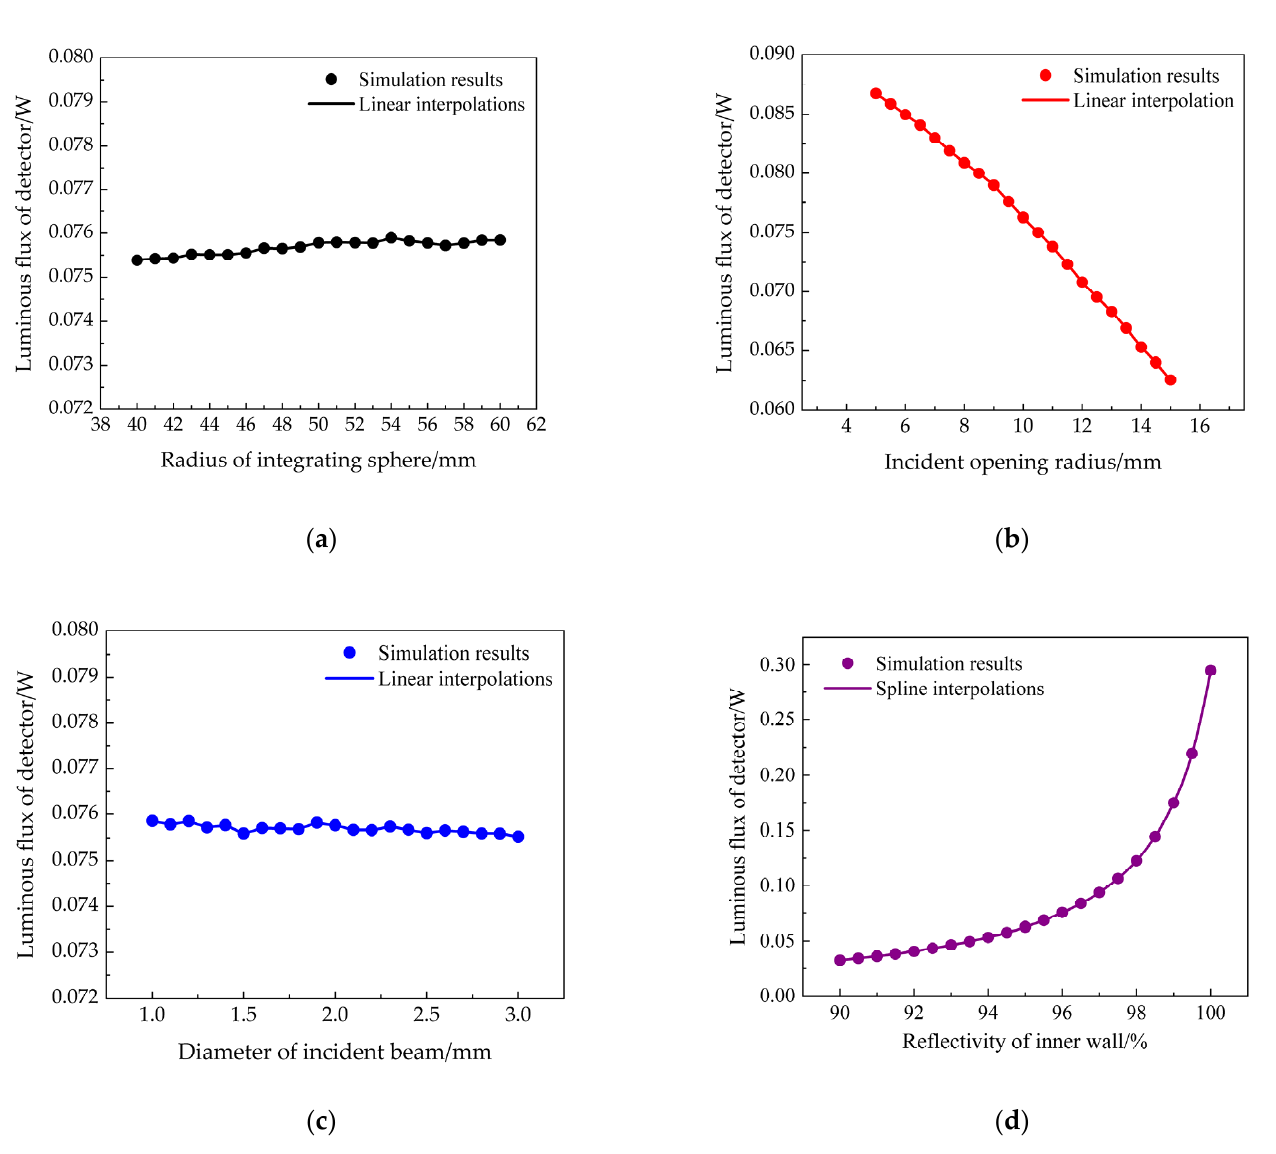
Figure 7. Influence of design parameters on the received luminous flux of the detector: ( a ) radius of the integrating sphere, ( b ) incident opening radius, ( c ) diameter of the incident beam and ( d ) reflectivity of the inner wall for the integrating sphere.